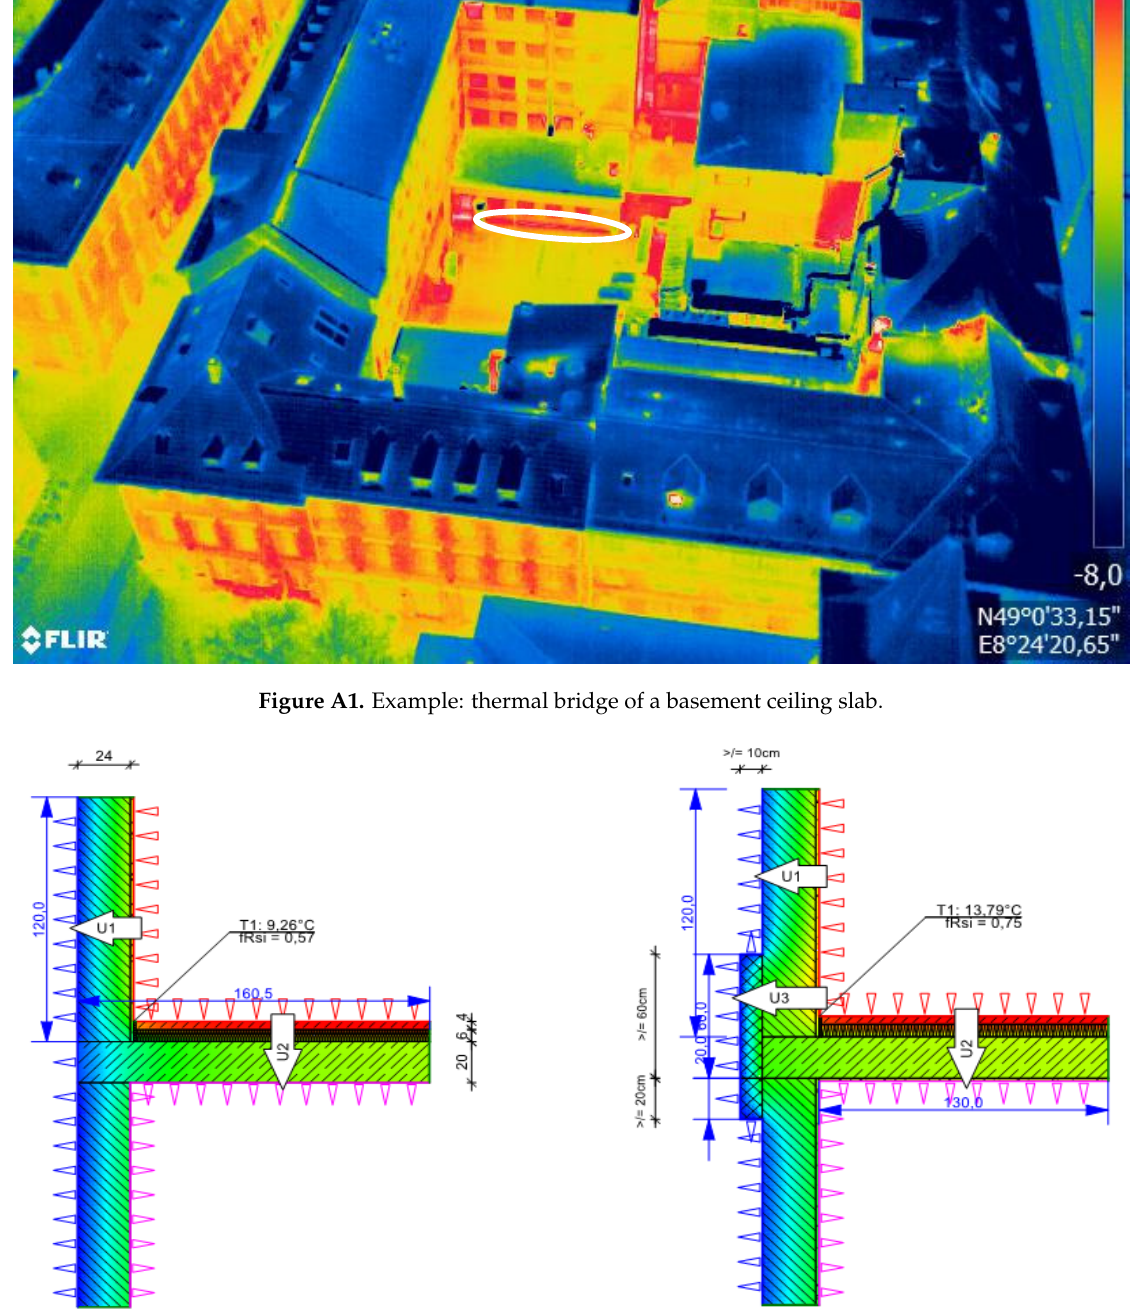
Figure A2. Before and after the thermal bridge retrofit of a basement ceiling slab (created with ThermCad thermal bridge simulation calculator).